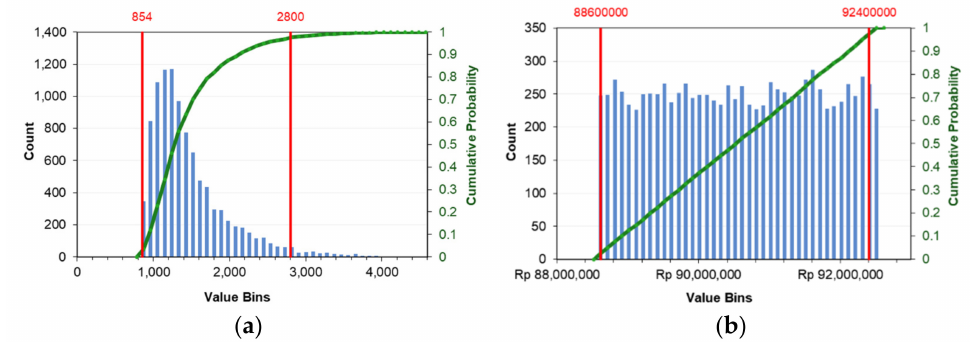
Figure 16. Histogram of BEP through MCS on Cantilever Crane: ( a ) Break-Even of Units; ( b ) Break- Even Revenues.